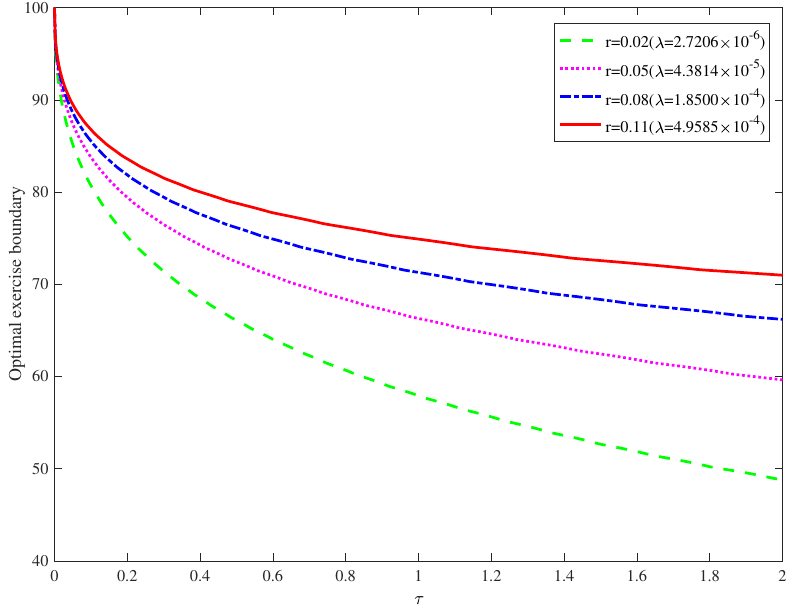
Figure 2. Optimal exercise boundary for different r (and λ ). ( T = 2, σ = 0.3, K = 100).